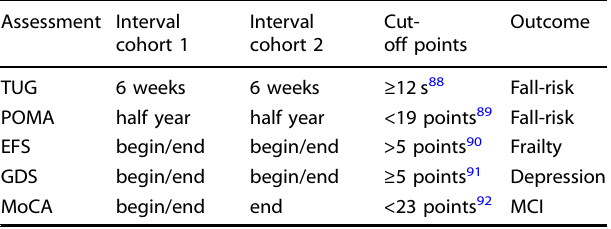
Table 5. Clinical assessments and employed cut-off points.